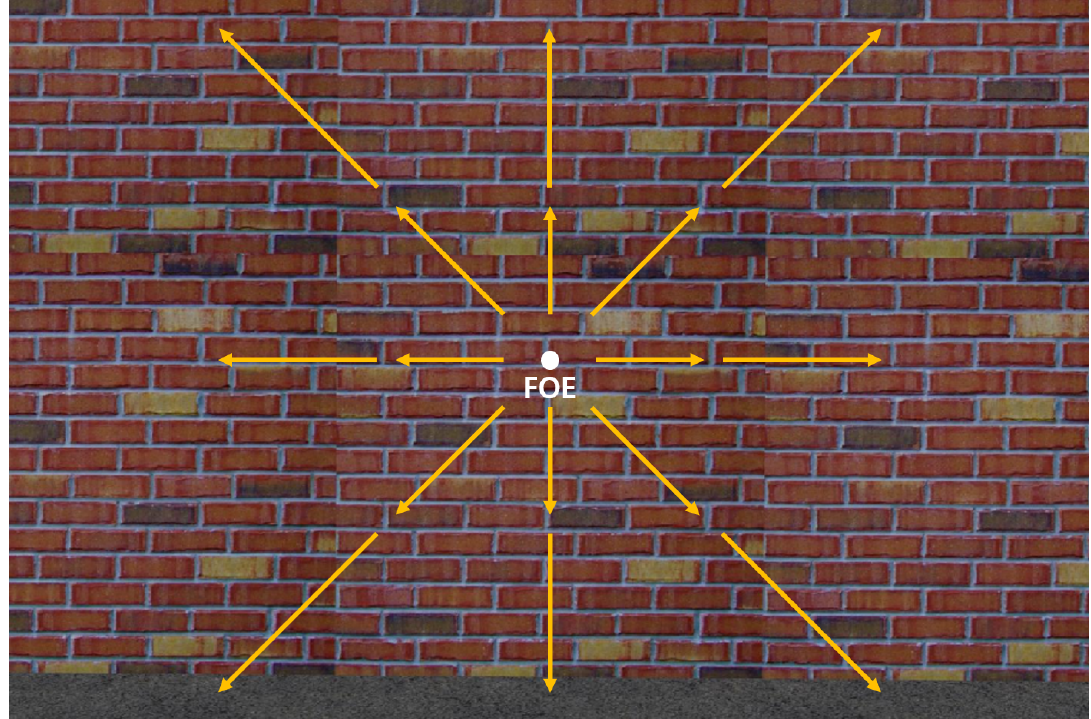
Figure 5. The optical flows diverge from the FOE when the MAV goes towards the obstacle